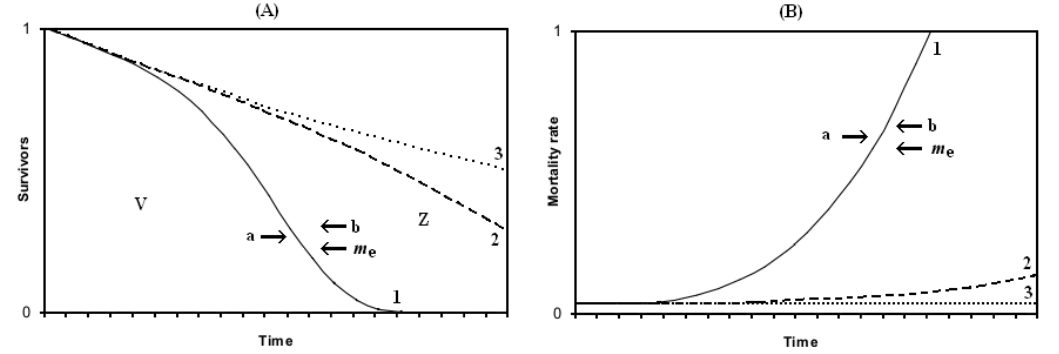
FIGURE 3. Nonadaptive hypothesis. The curves are the same as in Fig. 1. (A) The life table of an IMICAW species (Curve 1) is influenced by [a] = selection against ML-limiting factors; [ m e ] = extrinsic mortality (= m 0 + m w ); [b] = ML-limiting harmful factors. The hypothetical life tables without m i or without m i +m w (Curve 2 and Curve 3) are influenced only by the variations of m 0 + m w and of m 0 , respectively. (B) Mortality rate curves are influenced by the same